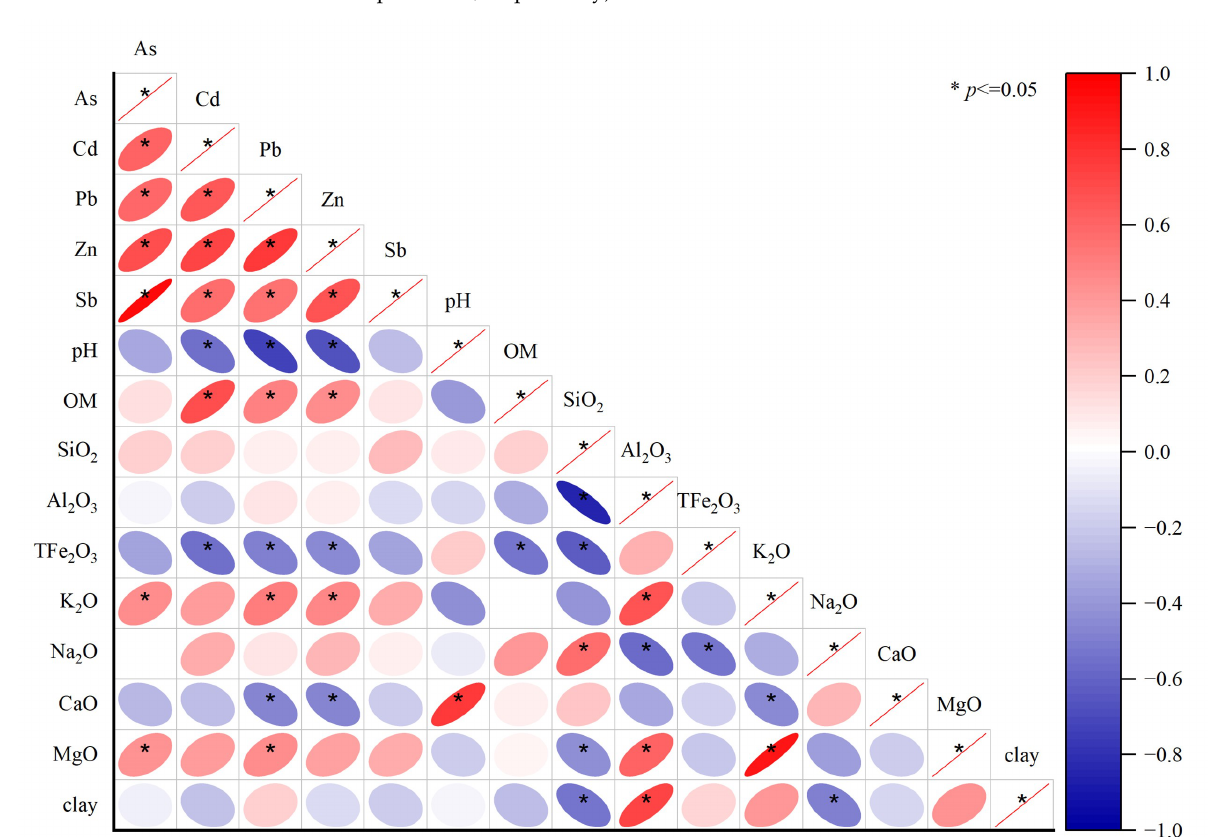
Figure 5. Distribution of the bioavailable fractions of heavy metals and metalloids in the profile soil. (The whiskers represent the minimum and maximum values, respectively, the dots are the mean values, and the three vertical lines in the boxes from left to right represent the 25th percentile, median, and 75th percentile, respectively).